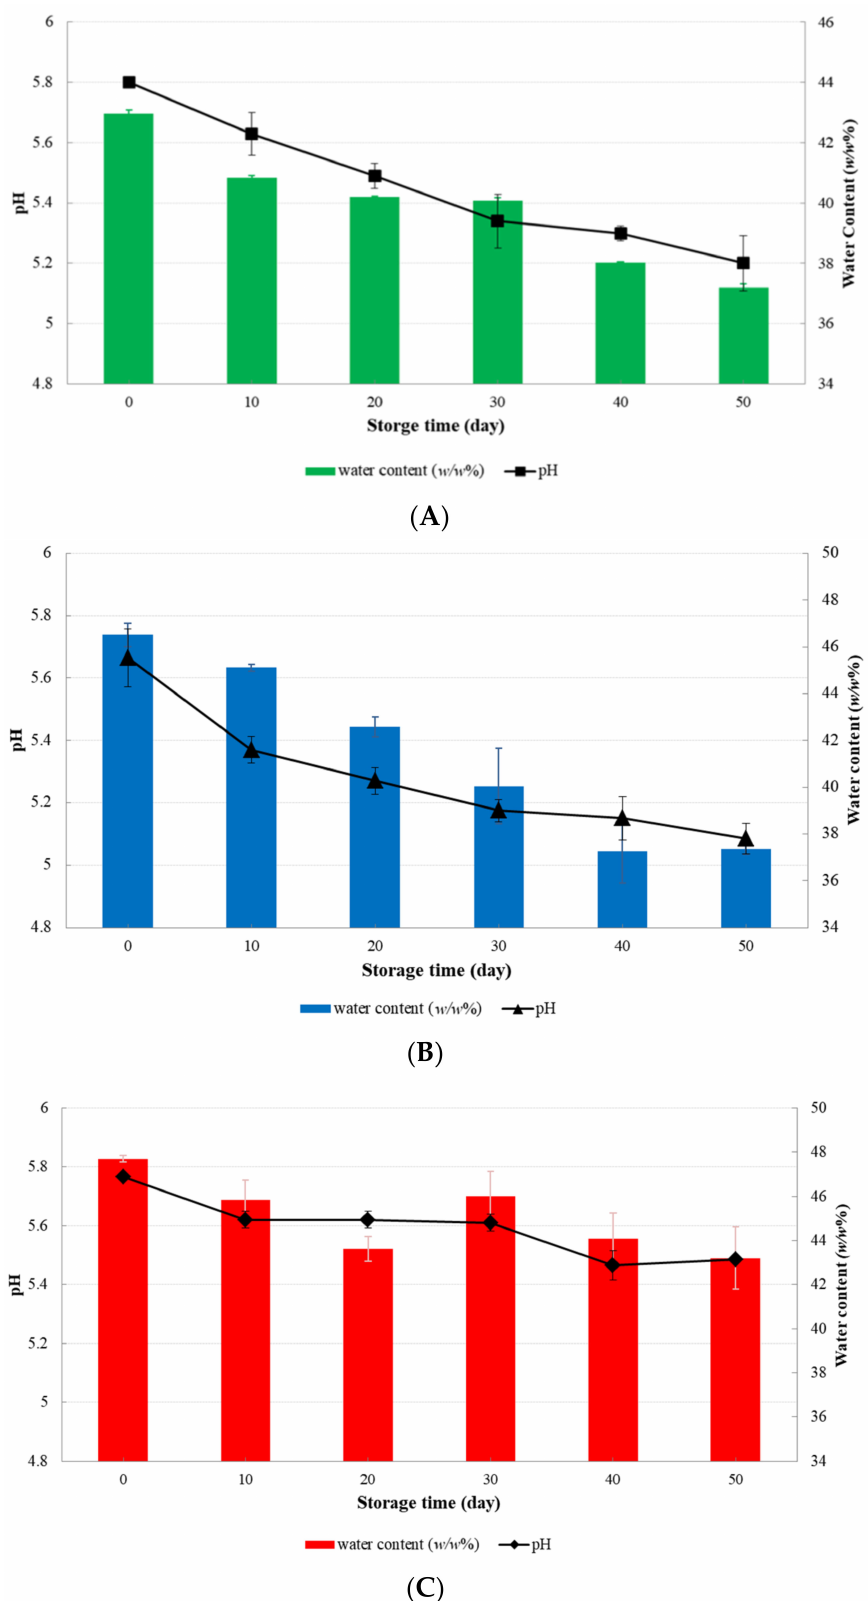
Figure 4. pH and Water content (%) of cheese- ddukbokki rice cake samples during 50 days at 10 ◦